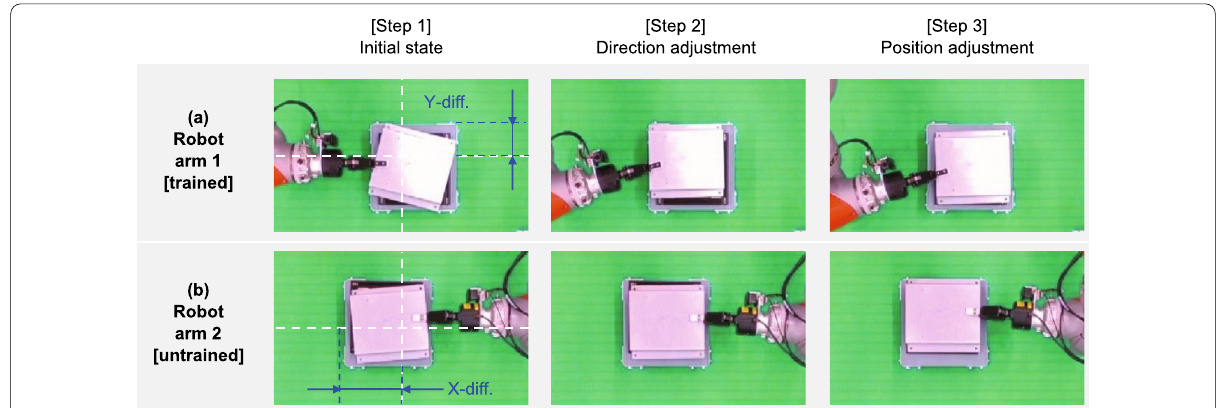
Fig. 8 Task execution result: positioning cover on randomly placed